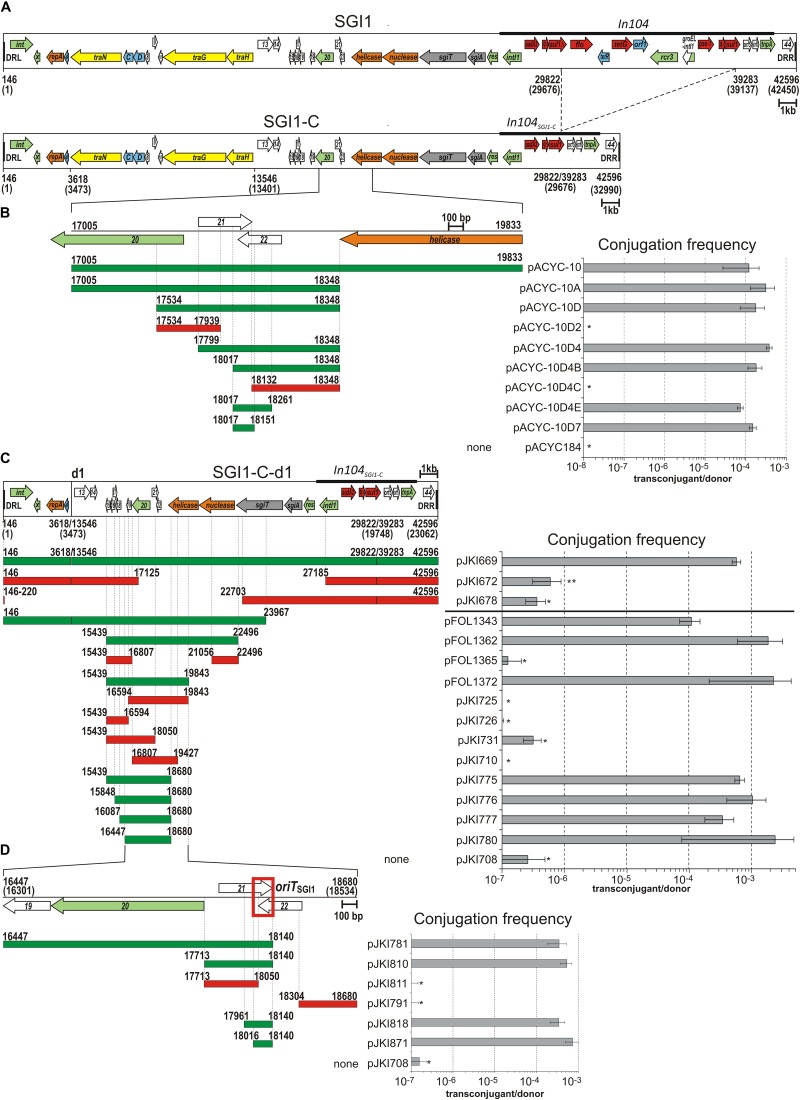
Identification of oriTSGI1. (A) Schematic map of SGI1 and SGI1-C. The annotated ORFs designated originally as S001-S044 are indicated by colored arrows: green – recombination, transposase; orange – replication; blue – transcription regulator; yellow – conjugation; gray – TA system; red – antibiotics resistance gene; white – unknown function. Names of genes with known function or identified homologs are indicated. Abbreviations: x - xis, C and D - flhDCSGI1, sgiT and sgiA – toxin and antitoxin gene of SGI1 TA system, qΔ – qacEΔ1, genes of unknown function are numbered according to their original numbering (e.g., “4” refers to S004, etc). Terminal direct repeats are shown as black boxes, In104 and its deletion derivative in SGI1-C are indicated. Coordinates are according to the published SGI1 sequence (AF261825) and refer to the ends of SGI1 (including DRs) and the endpoints of deletions led to the formation of SGI1-C and SGI1-C-d1 variants. The real coordinates of SGI1, SGI1-C and SGI1-C-d1 (taken into account of the missing A base from our SGI1 sequence at the 16338 bp position of AF261825) are indicated in brackets below the maps of SGI1 variants (5′-end of DRL was designated as the first position of SGI1). All maps are drawn to scale. (B) Identification of oriTSGI1 using the S. Agona 47SA97 (harboring R55 helper and the chromosomally integrated SGI1-CΔint) donor and the E. coli BM14 recipient strains for mating. The color-coded horizontal bars with coordinates represent the cloned SGI1 regions in the pACYC184-derivative plasmids: green – mobilizable; red – not mobilizable. The graph shows the transfer frequency of the plasmids. Frequency data were calculated as transconjugant/donor titres in each figure. Asterisk indicates that the transfer frequency was below the detection limit ( < 10-8/donor). (C) Identification of mobSGI1 region in SGI1-C-d1 variant. Conjugation frequency of SGI1-C-d1 variant carried by a p15A based vector and its p15A-based subclones was measured in the presence of the helper plasmid R55, but without chromosomal SGI1. Horizontal bars indicate the SGI1-derived sequences present in the test plasmids. For mobilization of the constructs carrying the SmR/SpR marker of SGI1-C-d1, TG1 donor and TG1Nal recipient, while for others, TG1Nal donor and TG2 recipient strains were used (separated by horizontal line). The asterisk indicates that the transfer frequency was close to or below the detection limits (<10-7/donor). The rare transconjugants obtained sporadically carried also the helper plasmid (co-transfer of the two plasmids was ∼100 %) suggesting an oriTSGI1-independent transfer mechanism (e.g., conduction, transfer of plasmids by cointegration with the helper). ∗∗In case of pJKI672, the NalRSmR colonies obtained with a frequency of ∼6 × 10-7 did not contain the transferred plasmid, thus were not real transconjugants. Other symbols are as in panels (A) and (B). (D) Identification of oriTSGI1 using mobSGI1-donor (harboring chromosomally integrated mobSGI1 and R55 helper) and TG2 recipient E. coli strains. The minimal fully mobilizable fragment designated as oriTSGI1 is indicated by red box, other symbols are as in panel (B).